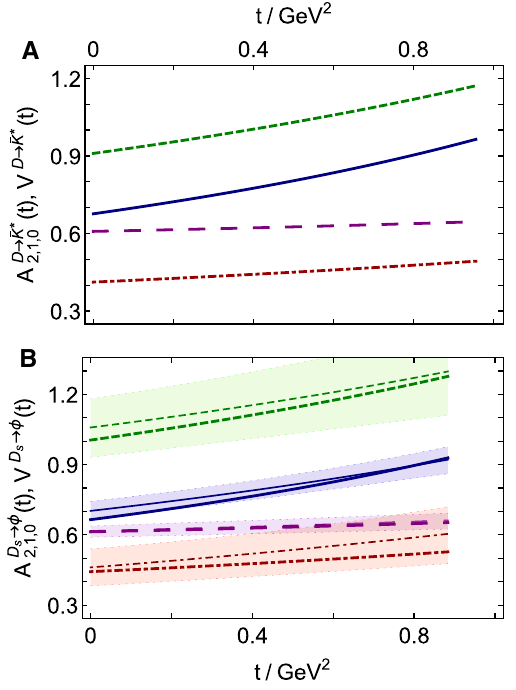
Fig. 2 A SCI predictions for D → K ∗ transition form factors: A 2 ( t ) – dot-dashed red curve; A 1 ( t ) – long-dashed purple; A 0 ( t ) – solid blue; V ( t ) – dashed green. B SCI predictions for D s → φ transition form factors, with legend as in A . Thinner, like-texture and -colour curves within shaded bands are lQCD results from Ref. [53]